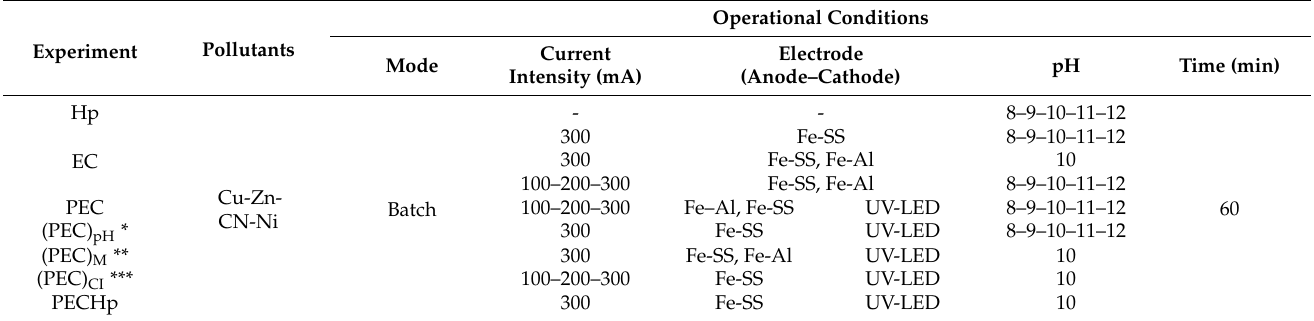
Table 2. Operational conditions used to remove cyanide and heavy